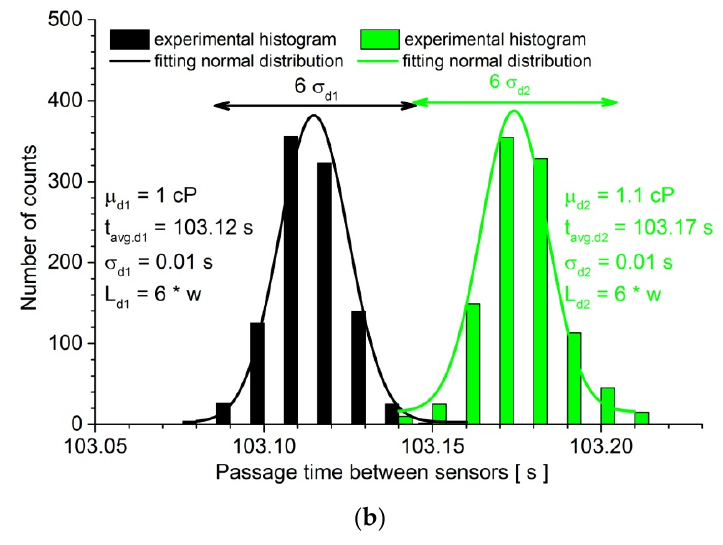
Figure 2. ( a ) The plot of the relationship between the viscosity of a droplet ( μ d ) and the time of passage between the sensors. The standard deviations of the passage time and droplet viscosity over ten samples were marked on the graph. ( b ) The chart shows the distribution of passage time of a droplet between the sensors. The experiment was repeated for the sample that consisted of 1000 independent droplets with the same viscosity ( μ d 1 = 1 cP and μ d 2 = 1.1 cP, water-glycerin solutions). The normal distribution was fitted to both histograms. The experiments were performed for ∆ p continuous phase = 100 mbar in temperature T = 37 °C.